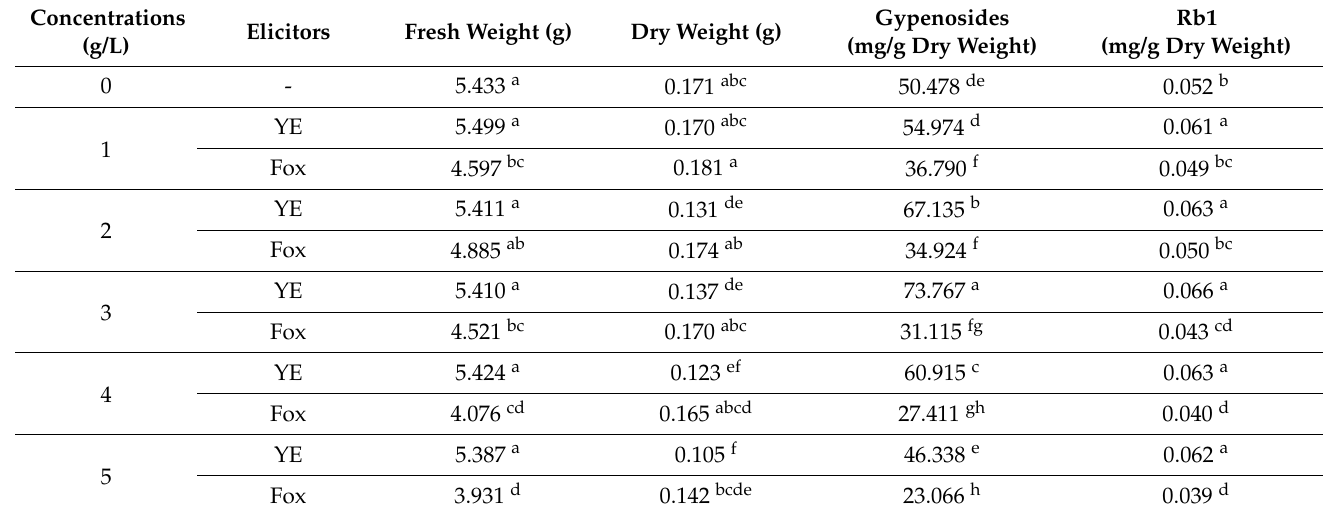
Table 2. Effects of concentrations of YE and Fox on the cell growth and gypenosides